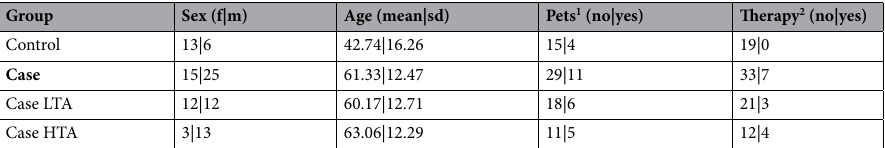
Table 1. Covariate data. List of covariates grouped by case and control samples as well as the identified classification into low Trichophyton abundance (LTA) and high Trichophyton abundance (HTA) subgroups 1 indicates if pets are in the household and/or the individual has contact to animals on a regular basis 2 indicates if the person had applied any treatment (topically and/or systemically) to the suspected